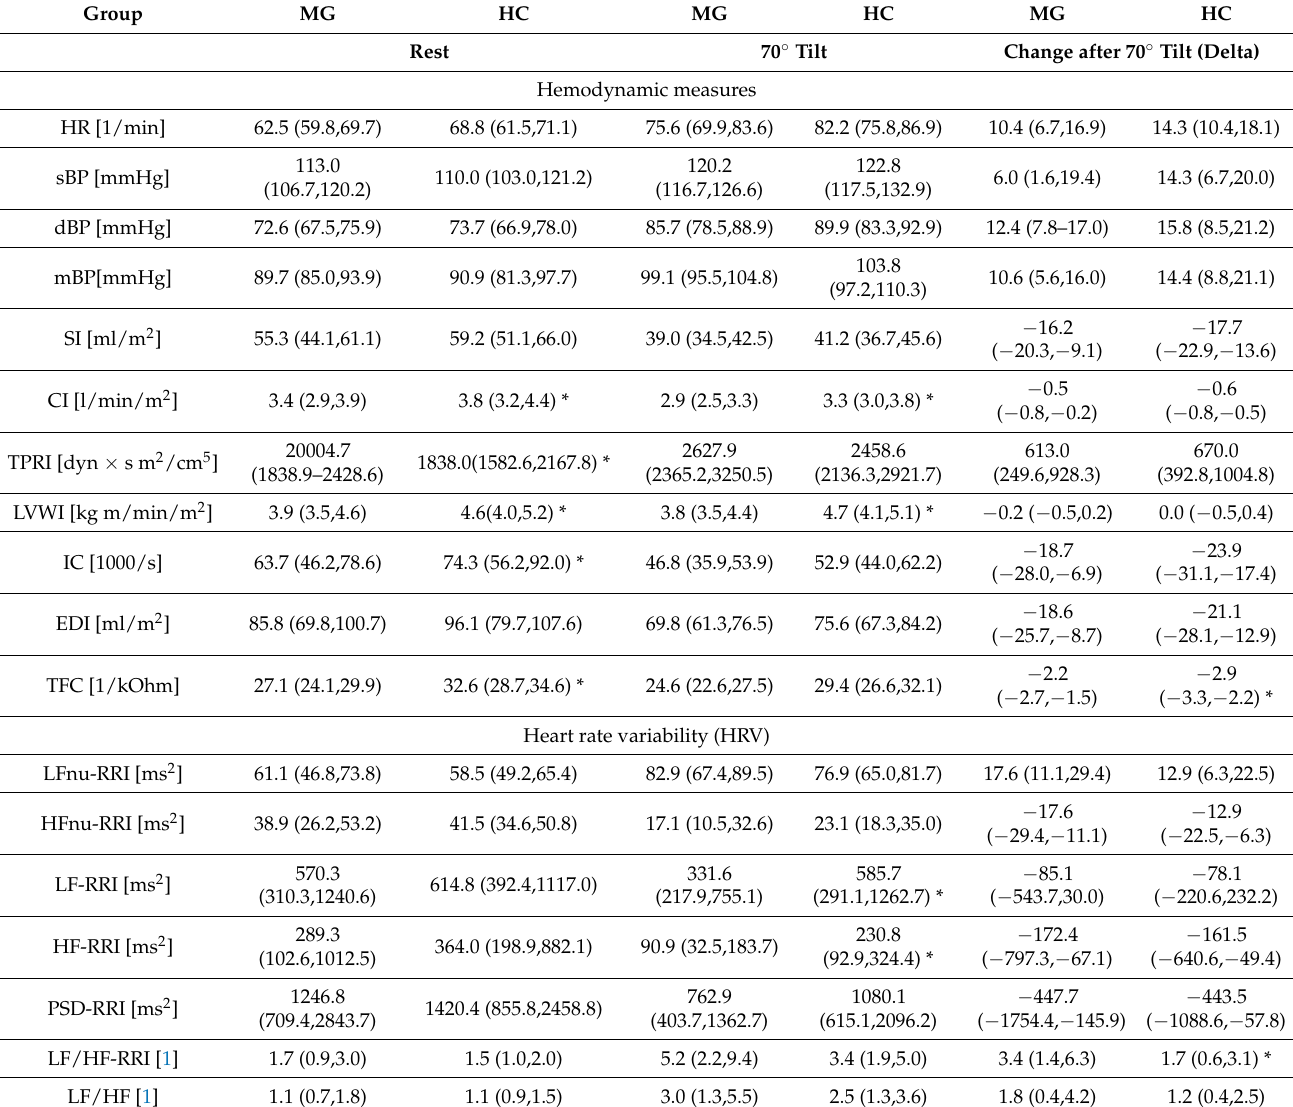
Table 2. Median (lower quartile–upper quartile) of hemodynamic and autonomic parameters for MG patients and healthy